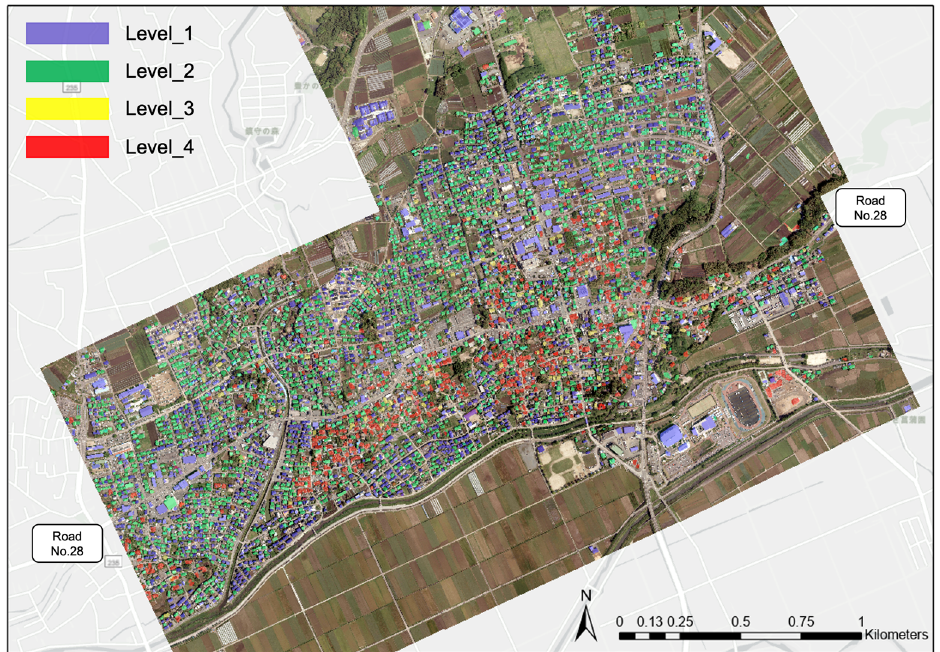
Figure 11. Obtained prediction map of all the buildings in the target area using the proposed model-10.